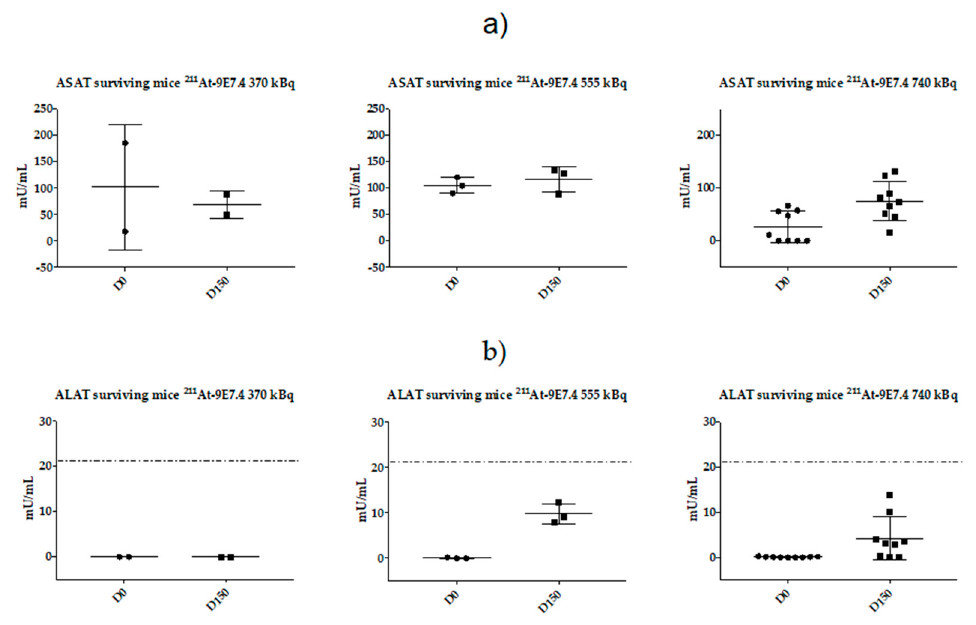
Figure 5. Hepatic toxicity of mice grafted with 10 6 5T33 MM cells then treated with 211 At-9E7.4. ASAT (aspartate aminotransferase) ( a ) and ALAT (alanine aminotransferase) ( b ) were measured on serum from all surviving mice 150 days after engraftment. Dashed lines on ALAT graphs indicated the upper normal limit for ALAT parameter (issued from [27]).